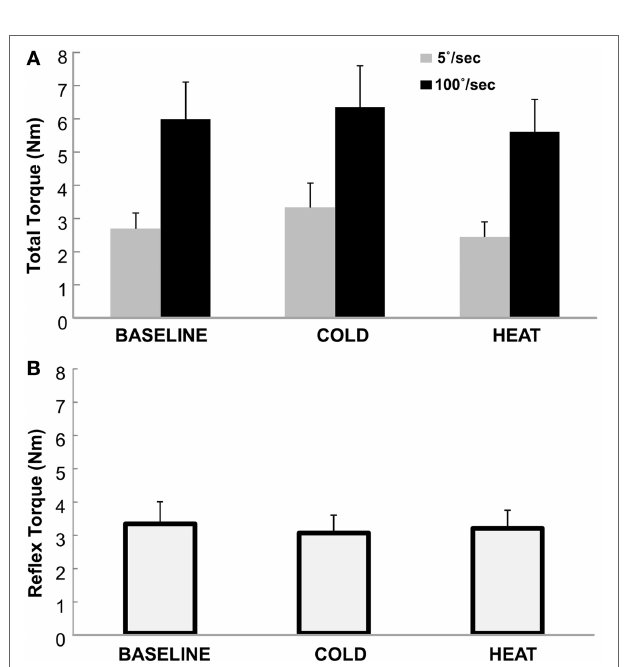
FigUre 3 | (a) Total Torque at BASELINE, COLD, and HEAT conditions. Gray bars indicate torque responses at slow stretch (passive component) and black bars indicate torque responses at fast stretch (passive + reflex component). A clear difference between speeds is visible, but not necessarily between temperatures. Mean and SEs are shown. (B) Reflex torque at BASELINE, COLD, and HEAT conditions. The reflex component of the total torque is the difference between the fast and slow torque responses (Total Torque at 100°/s − at 5°/s). Mean and SE are shown.